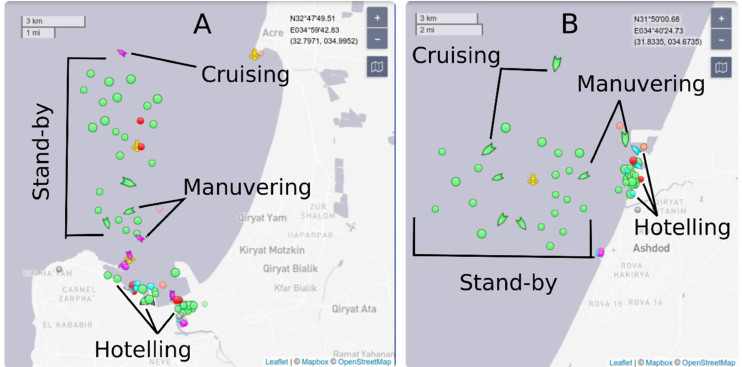
Figure 2. Differentiation between three marine navigation phases: cruising, stand-by and maneuver- ing, and hoteling. ( A ) Haifa port. ( B ) Ashdod port. Round icons represent stationary ships, arrow shaped icons represent sailing ships. Navigation phases: Stationary ships inside the port are hoteling ships; stationary ships outside of the port are stand-by ships; sailing ships between stand-by and the port are maneuvering ships (0.5–5 km from port); and sailing ships arriving to the stand-by position or leaving the port within 1–10 km from the port, are cruising ships. Port coordinates are in the top right of every panel. Data are from 24 July 2021, represents normal ports activity and is presented with permission from MarineTraffic [67]. The maps are by